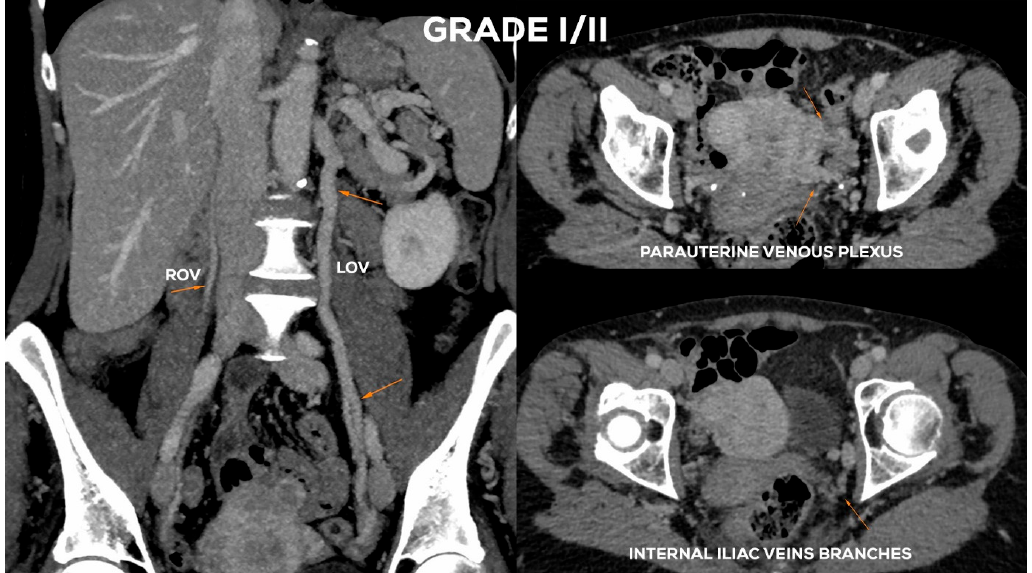
Figure 10. Typical findings in patient with Grade I/II ovarian veins insufficiency seen on a CTV images in coronal and axial planes.